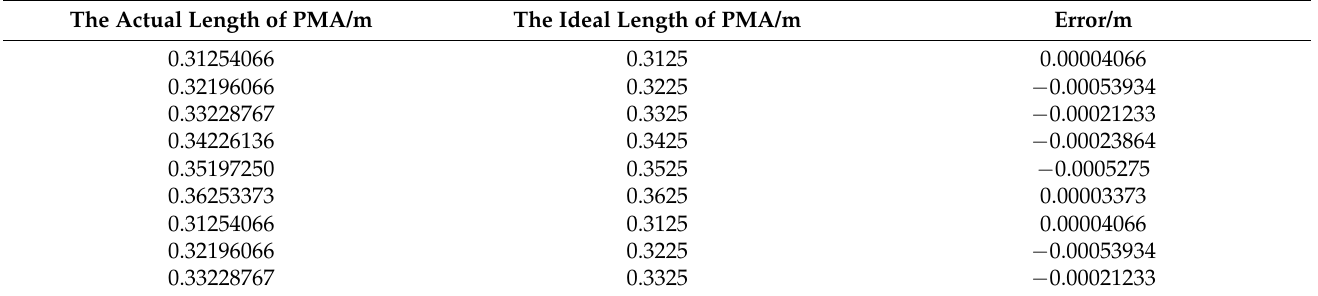
Table 1. Kinematic modeling